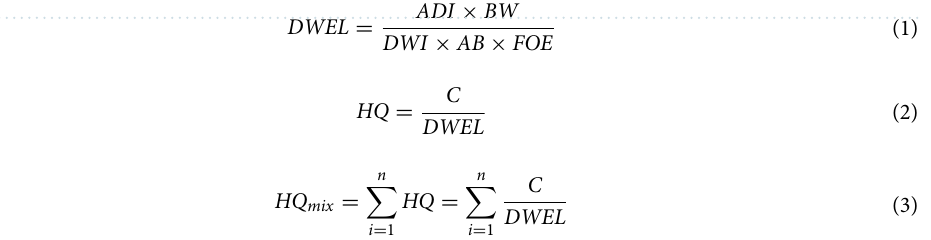
Figure 1. Groundwater sampling points and pollutant concentrations from the Fluorine Chemical Park (FCP) of Fuxin City, Liaoning